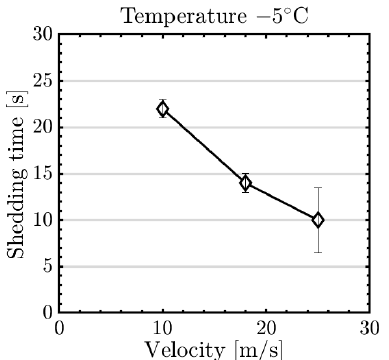
Figure 13. Comparison of shedding times between conventional (Conv.) and parting strip (PS) IPS, with activated (PS on) and deactivated parting strip (PS off).